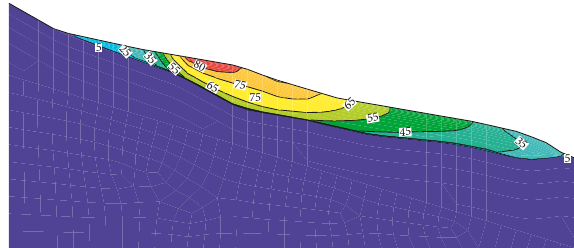
Figure 8: Elastoplastic calculation of horizontal displacement contour